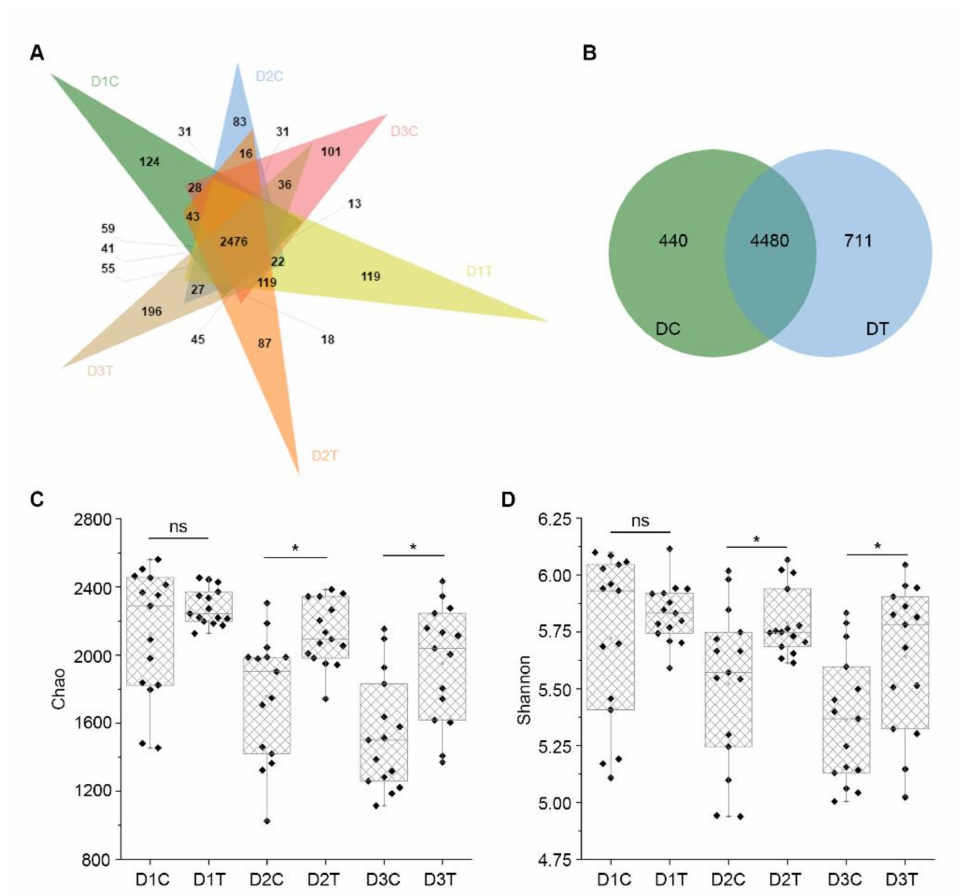
Figure 5. Analysis of bacterial diversity in soil samples. ( A ) Venn diagram of OTUs between each soil group in bacteria. DT refers to soil samples derived from plots treated with Bacillus subtilis strain Bv17, and those that came from plots treated with water are labeled DC. Soil samples were collected at two-month intervals three times (D1C, D1T, D2C, D2T, D3C, and D3T). ( B ) Venn diagram of OTUs between DC and DT. ( C ) The box diagram of alpha diversity of the Chao index in each soil groups. ( D ) The box diagram of alpha diversity of the Shannon index in each soil groups. Asterisks indicate statistically significant differences at p < 0.05 according to pairwise t -tests, and ns means no significant difference between